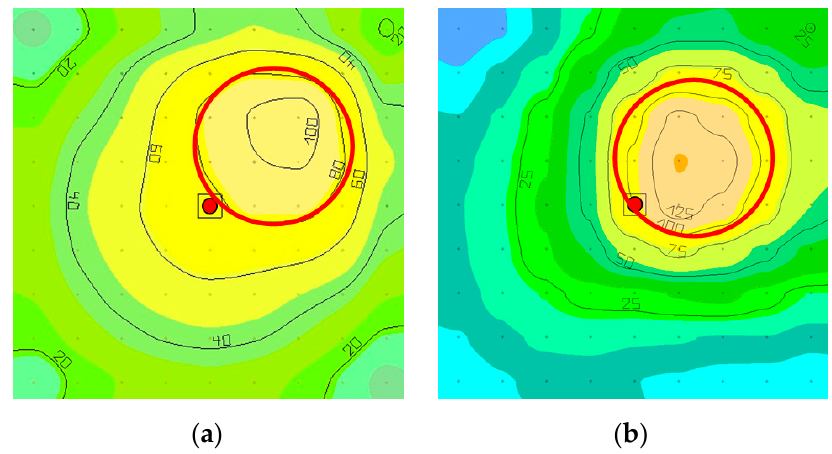
Figure 28. Option 2, illuminance distribution on the plane for asymmetrical distribution ( a ) results for a simulation model, ( b ) results for a luminaire prototype.